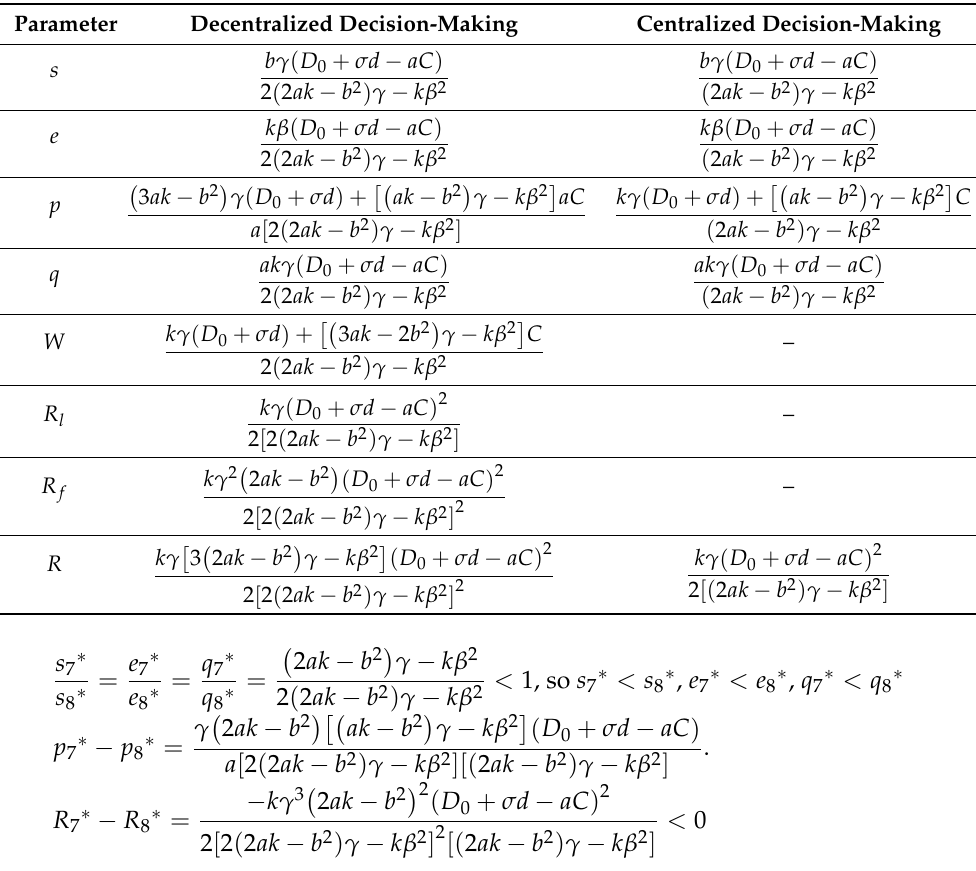
Table 4. Variable values and profits of different decision-making modes.